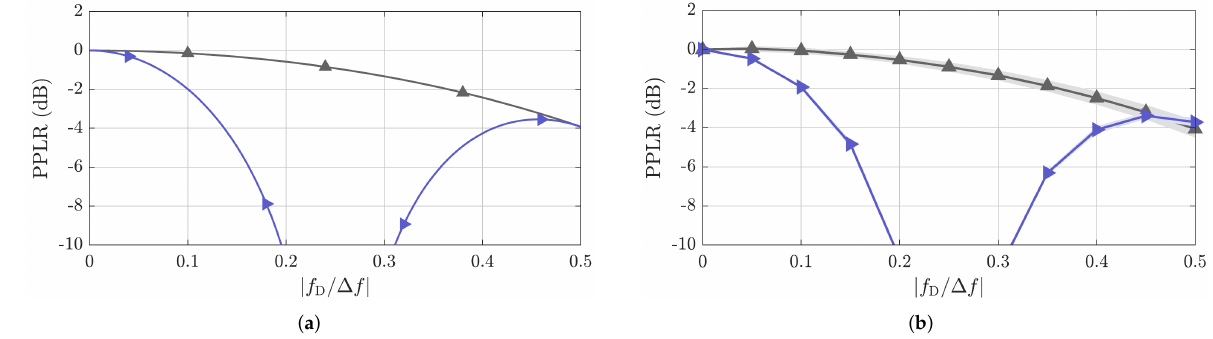
Figure 8. Simulated ( a ) and measured ( b ) PPLR as a function of f D / ∆ f . Except for the combination of complementary sequences Golay A and B ( (cid:73) ), which achieves the same PPLR profile for all N PRBS values, all other considered PRBSs listed in Table 1 ( (cid:78) ) achieve the same result. For the measurement results, the mean PPLR values are shown as solid lines, and their standard deviations are indicated by the shading in the